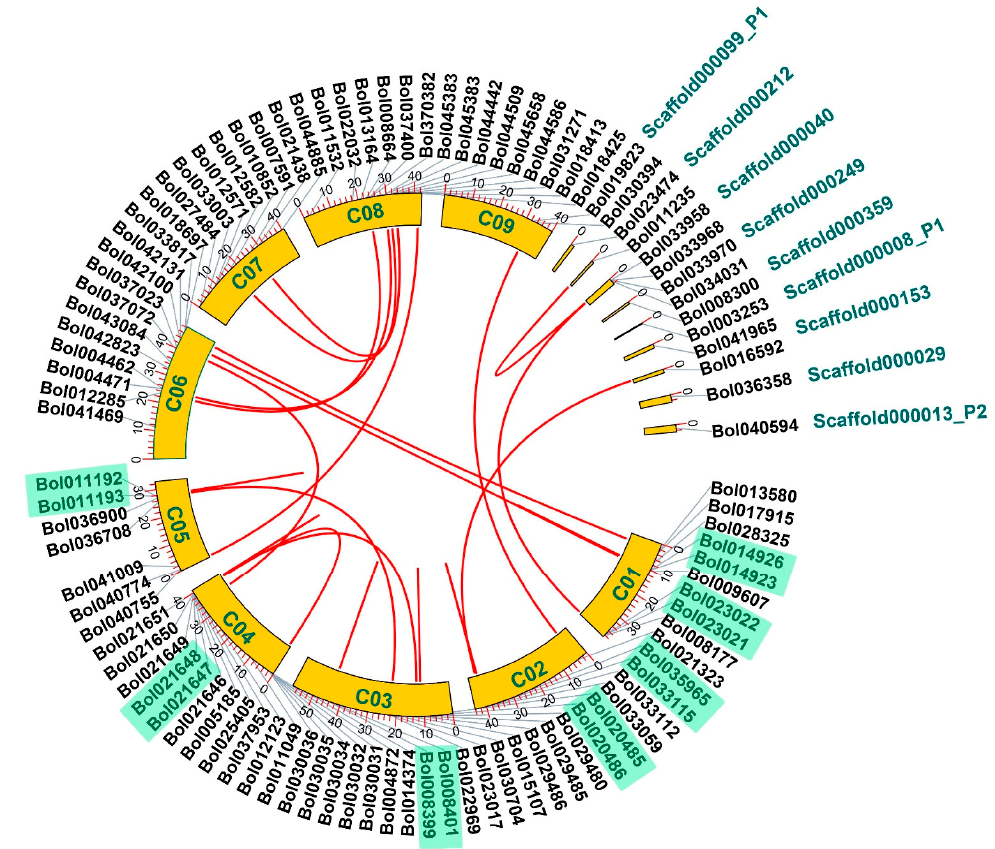
Figure 3. Genomic distribution and syntenic analysis of PG genes in B. oleracea . The chromosome numbers C01 to C09, and nine sca ff olds are demonstrated by green letters. Tandem-duplicated genes are indicated by the green background. The red lines represent syntenic relationships of the paralogous